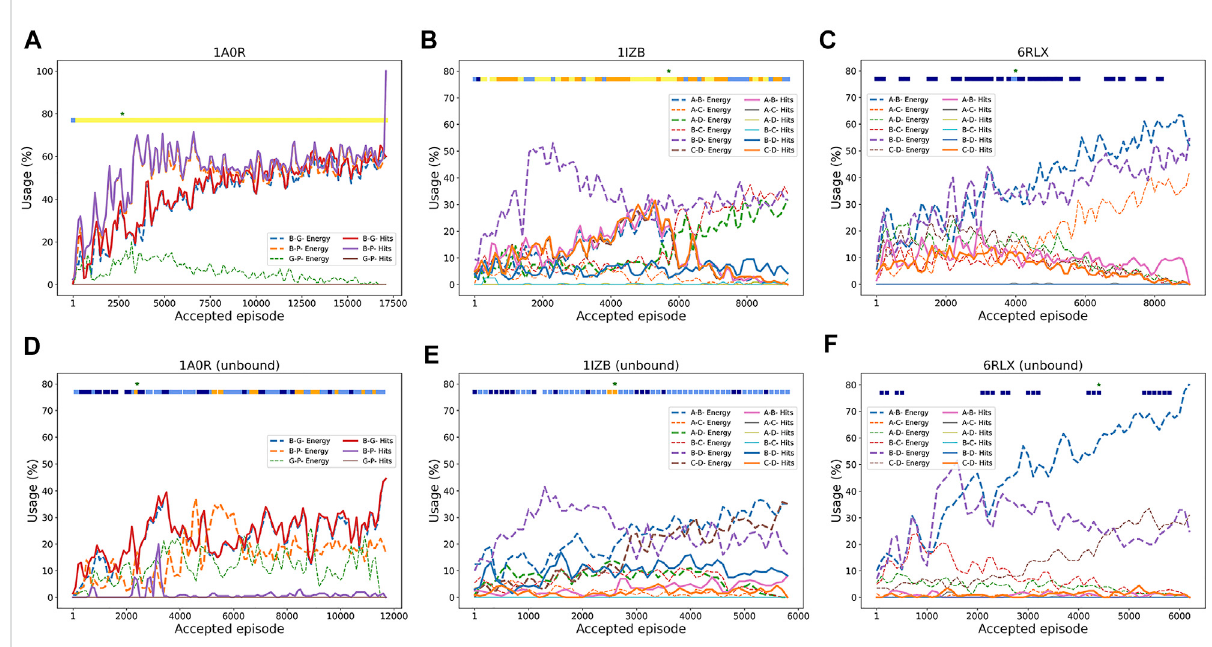
duetomanyclasheswerenotcounted. Thegreenstar “ * ” atthetopofthepanelrepresentstheepisodewhere thebestRMSDmodelwasfound.The colored squareboxesatthetopofeachplotrepresentsRMSDrangesofmodelsgeneratedatalongtheepisodes:yellow, 0 – 2 Å;orange2 – 4